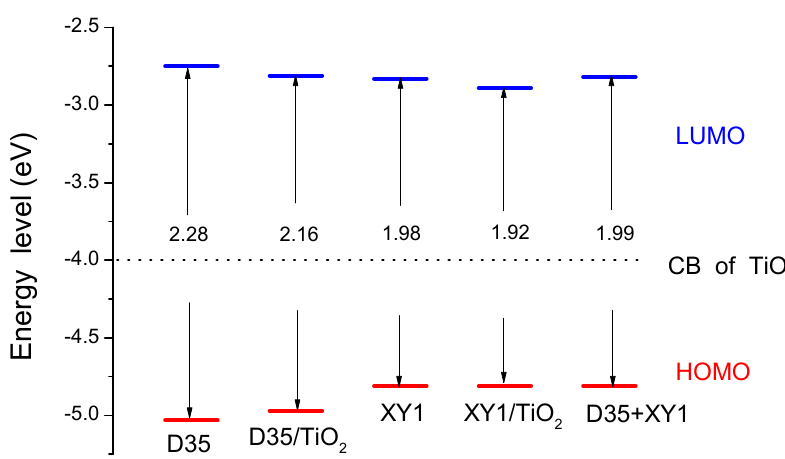
Figure 2. Energy levels of the isolated dye in acetonitrile and its adsorption spectrum on TiO 2 as well as cosensitized molecular system.